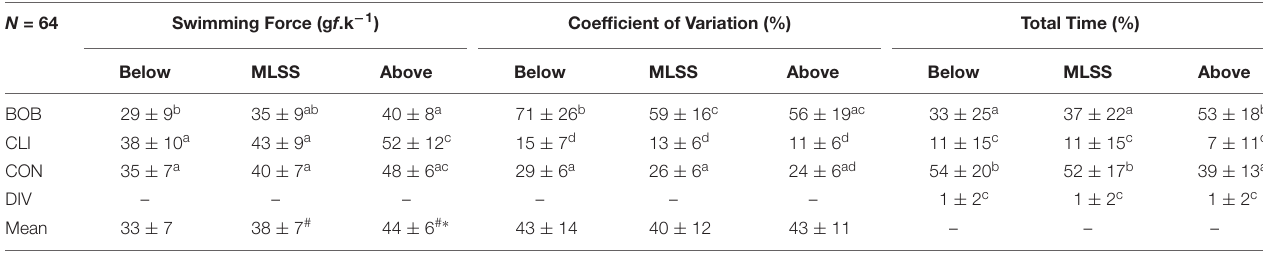
TABLE 3 | Mean values of swimming force (SF), coefficient of variation (CV), and percentage of time spent in each swimming pattern (total time) for bobbing (BOB), climbing (CLI), continuous (CON), diving (DIV) at intensities below, equivalent, and above the MLSS, of 64 rats. N = 64 Swimming Force (g f .k − 1 ) Coefficient of Variation (%) Total Time (%) Below MLSS Above Below MLSS Above Below MLSS Above